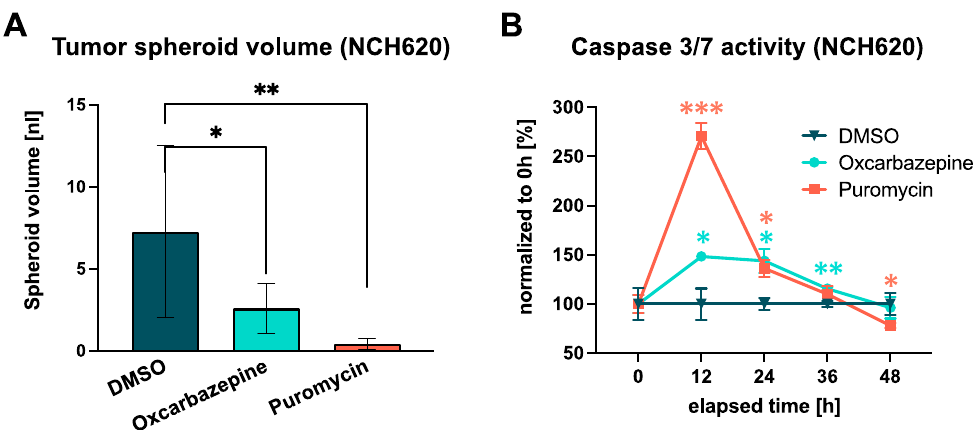
Figure 5. Impact of oxcarbazepine on tumor spheroid growth and the induction of apoptosis in NCH620. ( A ) Comparison of tumor spheroid volumes in a single well of each treatment condition, showing a significant growth inhibition for oxcarbazepine and puromycin. ( B ) Time-resolved induction of apoptosis measured through caspase-3/7 activity. A significant increase in apoptosis after incubation with oxcarbazepine (30 µ M) was seen after 12 h. Puromycin served as a positive control (4 µM). * p ≤ 0.05; ** p ≤ 0.01; *** p ≤ 0.001.